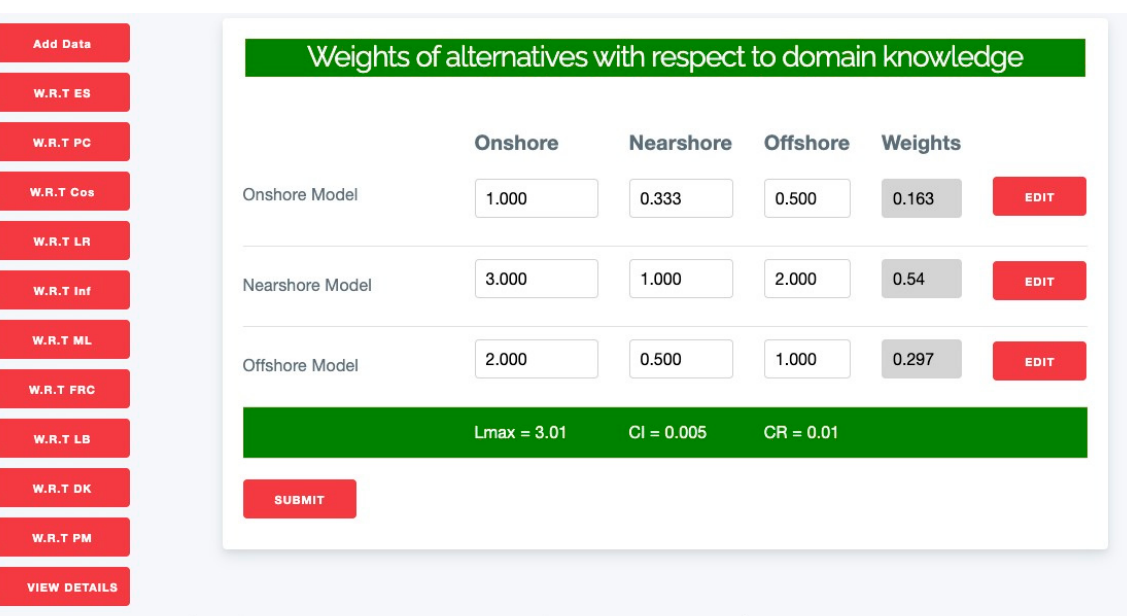
Figure A7. Alternatives weights with reference to LB and CR.